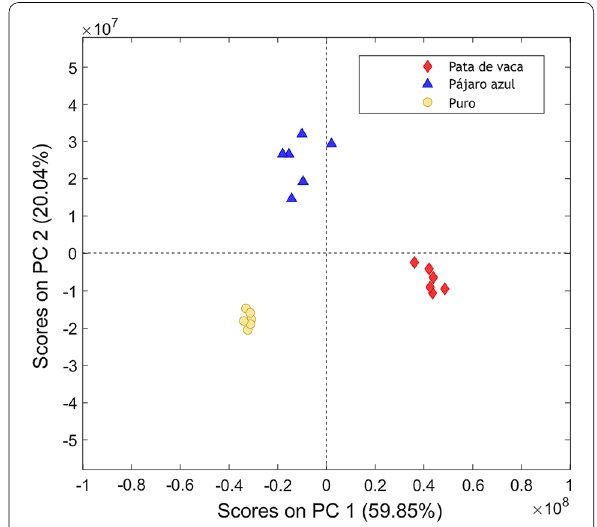
Fig. 2 PC1 vs PC2 scores plot obtained from the Ecuadorian spirits